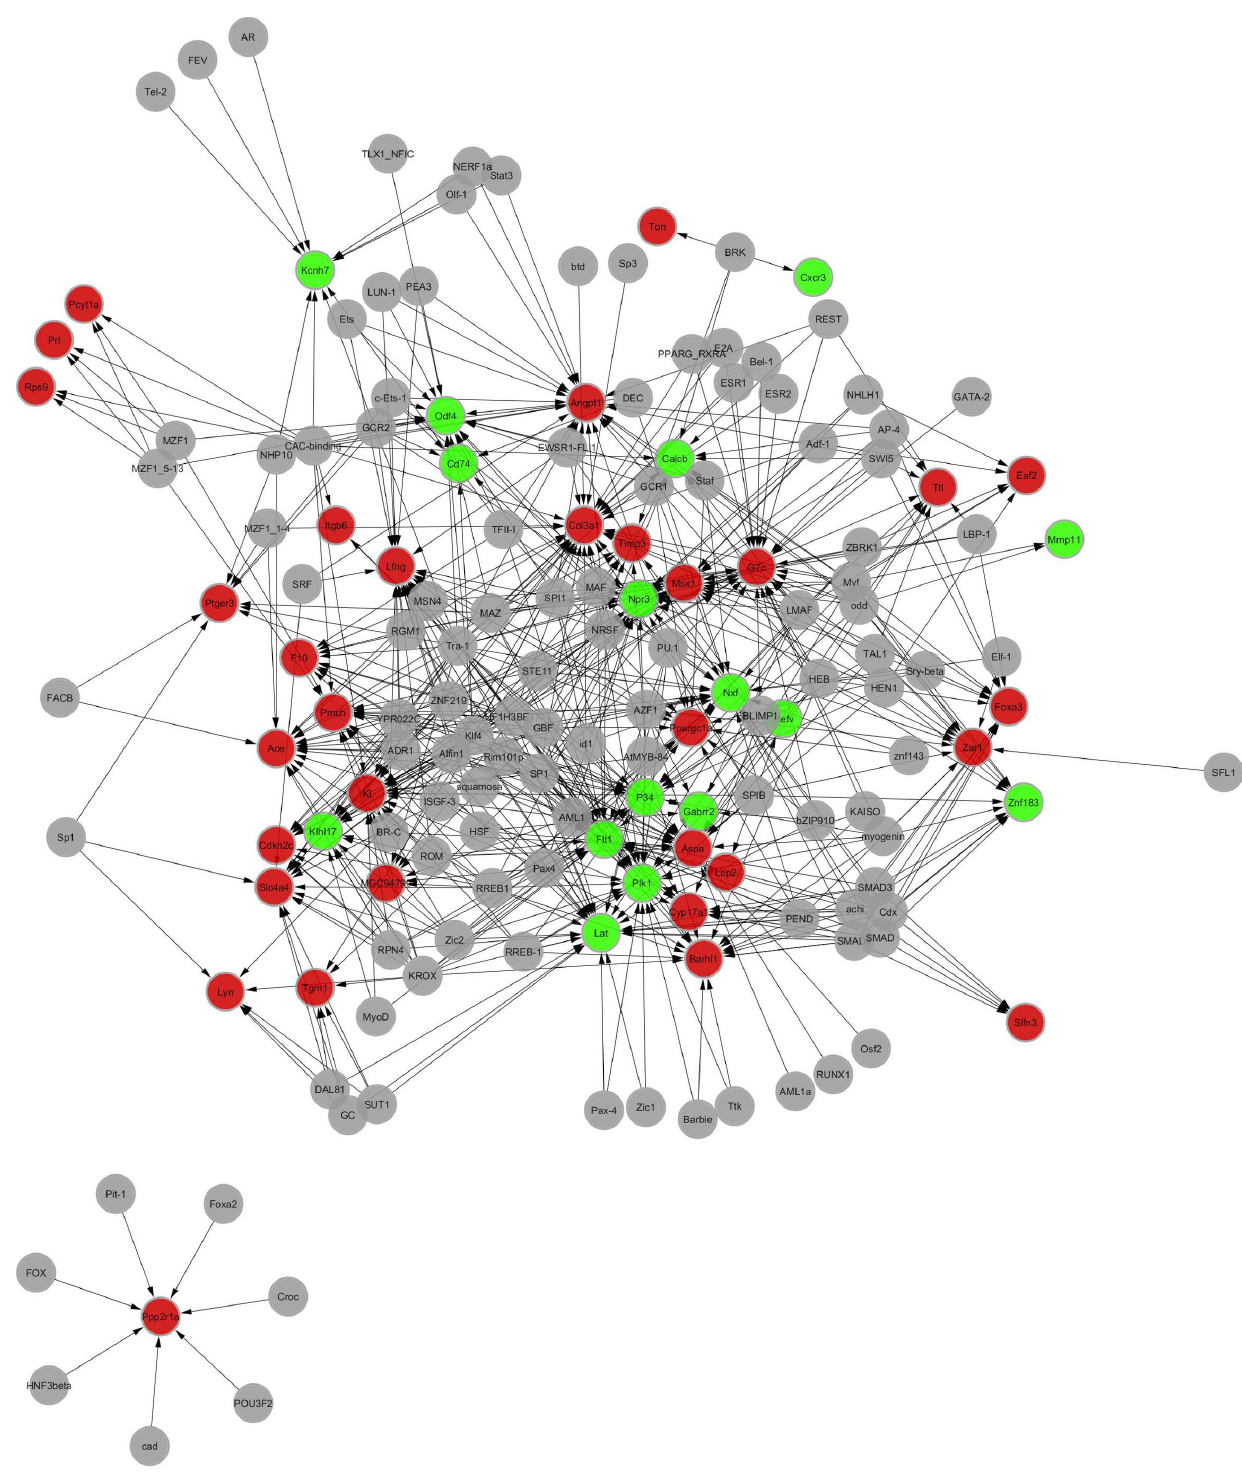
Figure 3. Visual diagram of the differential gene transcription regulation network of the 7-day stress group in comparison with the control group. The red represents up-regulate genes, the green represents down-regulate genes, the grey represents transcription factor. The arrow indicates the direction of TF target genes (TFT) regulated by transcription factor (TF). doi:10.1371/journal.pone.0057621.g003 the 21-day stress group, 39 were involved in the establishment of In the transcription regulation network, 141 nodes (including TF transcription regulation network, of which 22 were up-regulated and target gene) and 384 pairs of TF R TFT potential relationships and 17 were down-regulated. A total of 102 TFs were predicted. were involved. The PageRank values of the first 10 core genes in